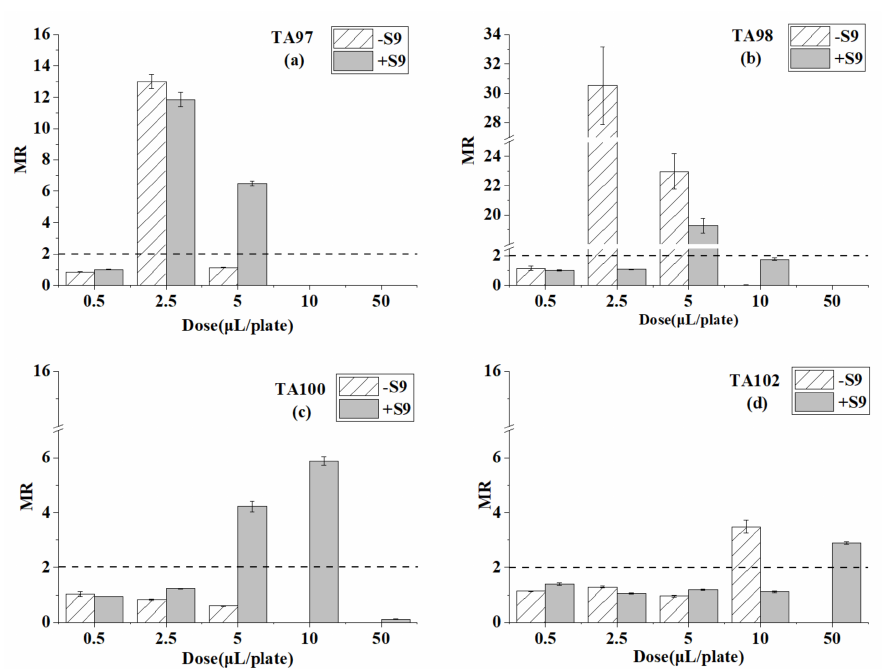
Figure 1. Mutagenesis of toluene to four strains in the presence and absence of S9 liver extract; ( a ) TA97 strain; ( b ) TA98 strain; ( c ) TA100 strain; ( d ) TA102 strain. The mutagenicity ratio (MR) is the average ratio ( ± SE) from three parallel